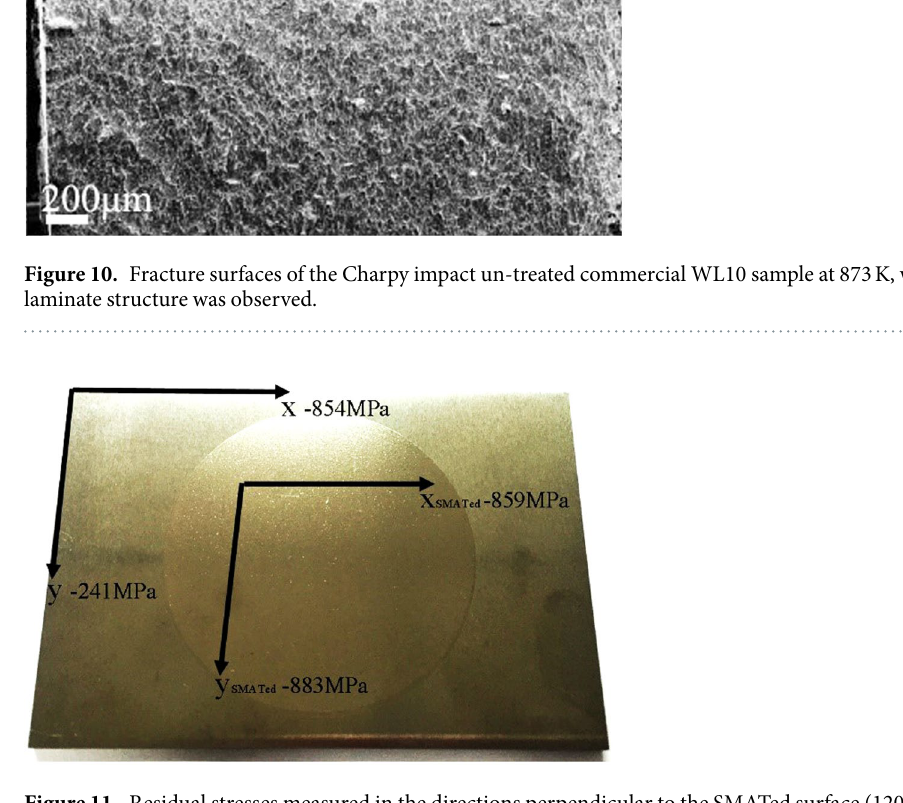
Figure 11. Residual stresses measured in the directions perpendicular to the SMATed surface (120 mm long in the ×